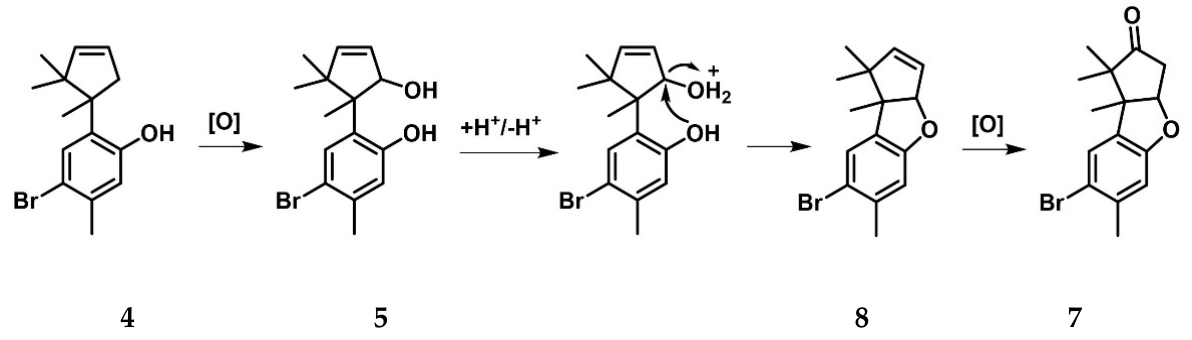
Figure 6. Proposed biosynthetic pathway of compounds 4 , 5 , 8 , and 7 .